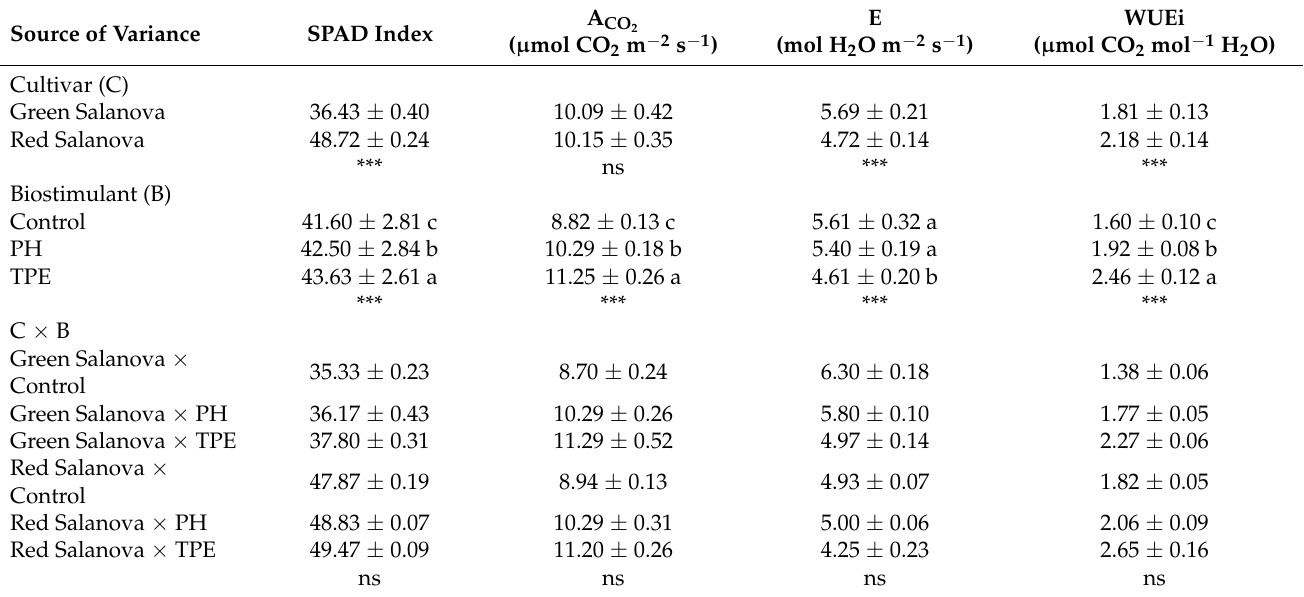
Table 4. Physiological parameters of red and green salanova lettuce and the influence of biostimulant